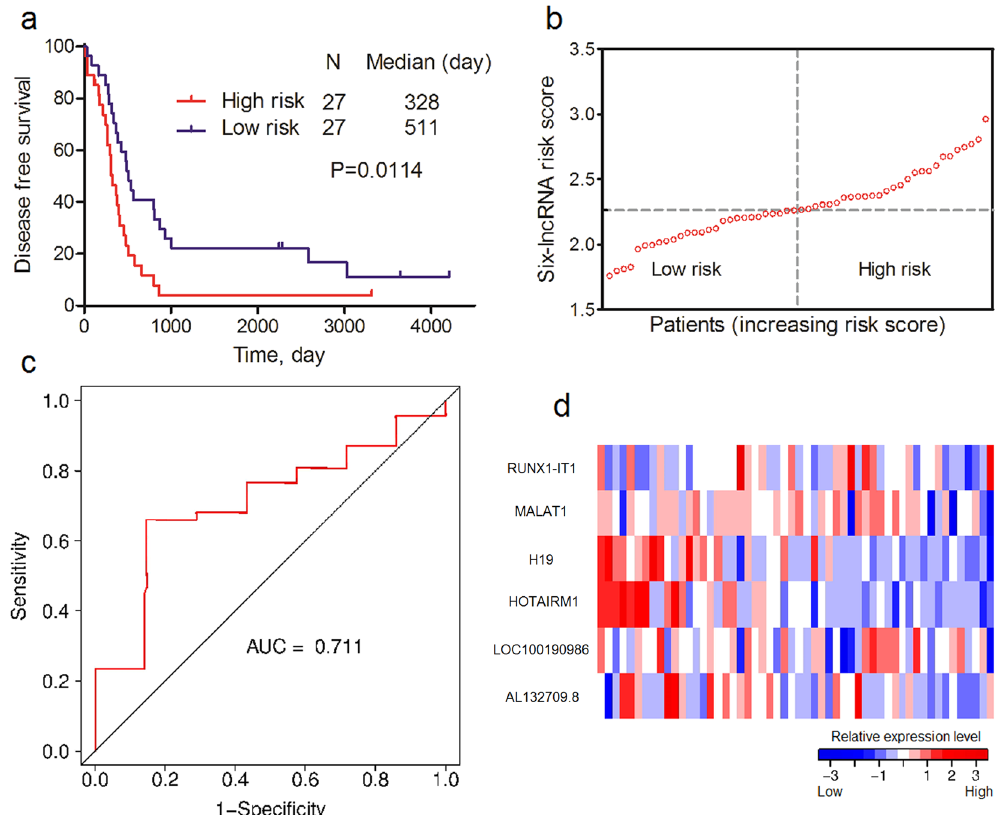
Figure 3. Association between six-lncRNA signature and DFS of OvCa patients in GSE30161 external validation cohort. ( a ) K-M curve of DFS between low- and high-risk patients. ( b ) Risk scores of each patient in GSE9891 internal validation cohort (sorted by risk score). ( c ) Time-dependent ROC curve analysis of the DFS prediction based on the risk score with three years as the time point. ( d ) Expression heat map of six lncRNAs in OvCa patients in the GSE30161 external validation cohort (sorted by risk